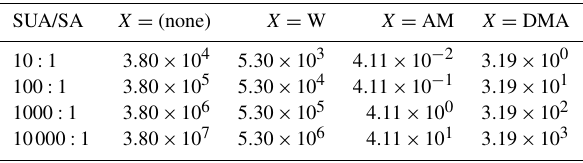
Table 7. Concentration ratios between SUA clusters, with X = W, AM, and DMA.